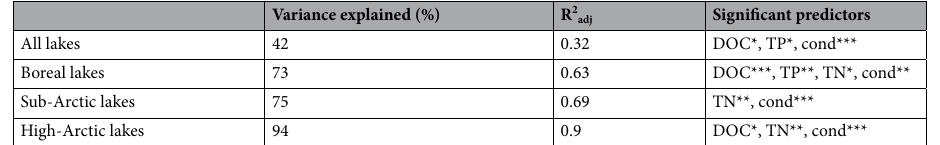
Table 2. Model outputs of the general additive models (CO 2 :O 2 ̴ s(DOC) + s(TP) + s(TN) + s(cond)) for the different regions. Significance codes: ***p < 0.001, **p < 0.01, *p < 0.05, non-sig p > 0.05.